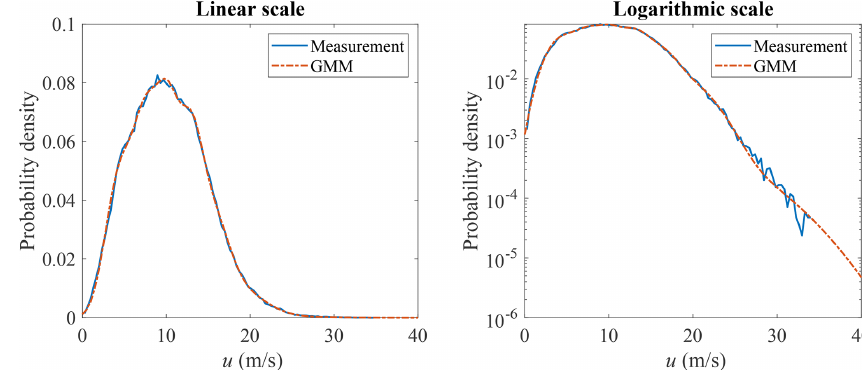
Figure 10. Marginal distribution of u for the offshore sector.